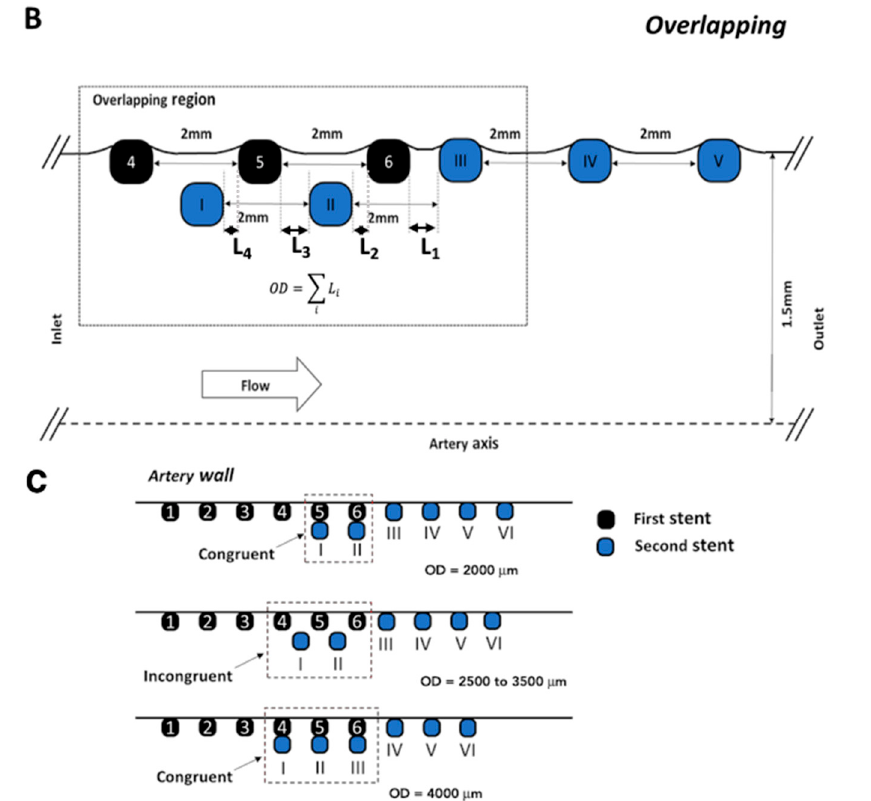
Figure 1. ( A ) Single stent geometry with three malapposed struts (# 1, 2, and 3) and three correctly apposed struts (# 4, 5, and 6) and ( B ) two overlapping stents (first stent: struts # 1 to 6, second stent: struts # I to (VI) and ( C ) 3 overlapping configurations, with two congruent struts, with incongruent struts and three congruent struts.